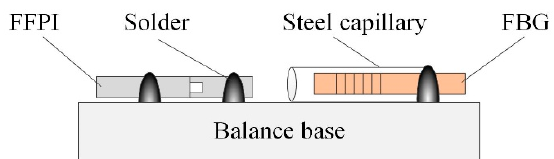
Figure 10. Schematic drawing of bonding techniques of FFPI and FBG sensors.